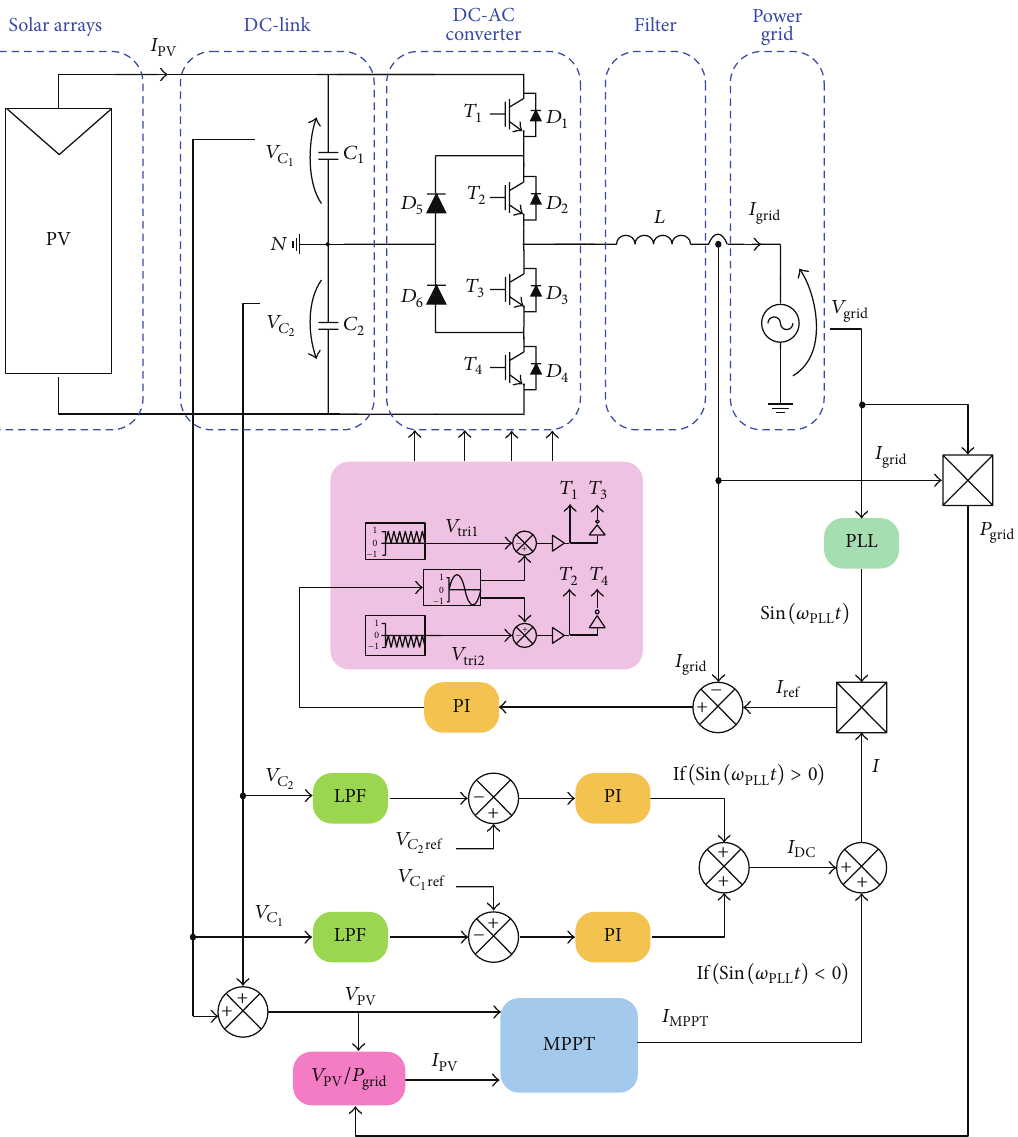
Figure 3: Scheme of the control system including the